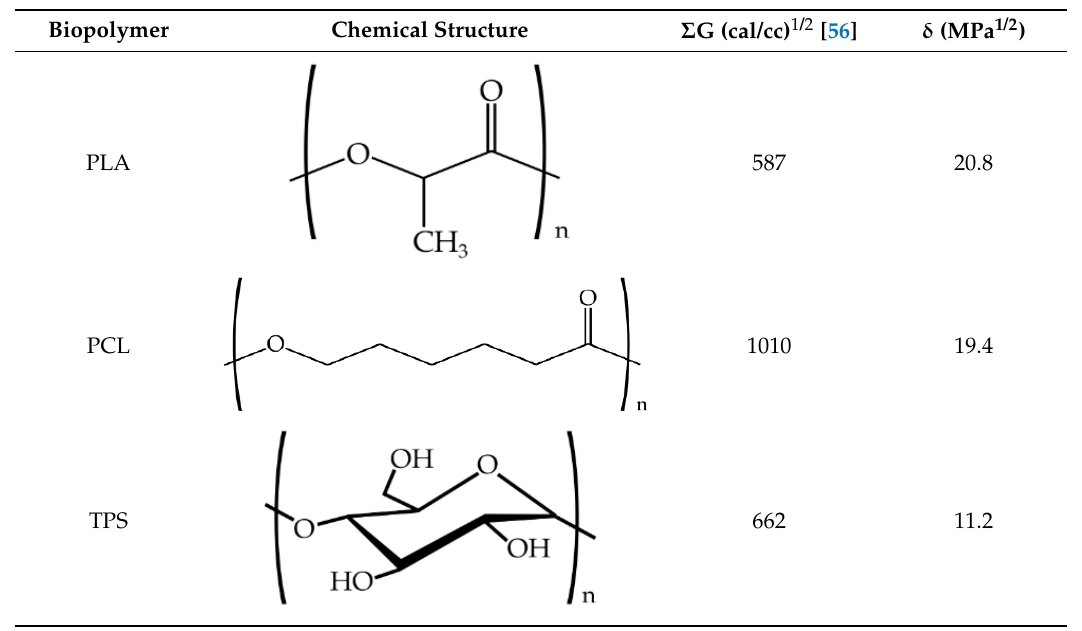
Table 3. Values of the solubility parameters ( δ ) obtained for polylactide (PLA), poly( ε -caprolactone) (PCL), and thermoplastic starch (TPS).